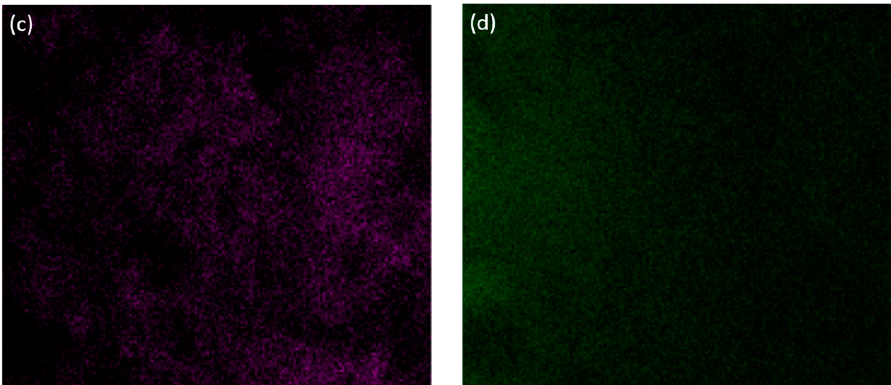
Figure 3. Scanning electron microscope (SEM) image of the sulfur cathode with the Thiokol binder before ( a ) and after ( b ) cycles, and Energy Dispersive X-Ray Spectroscopy (EDX) of carbon ( c ) and sulfur ( d ) of the cathode after cycles.